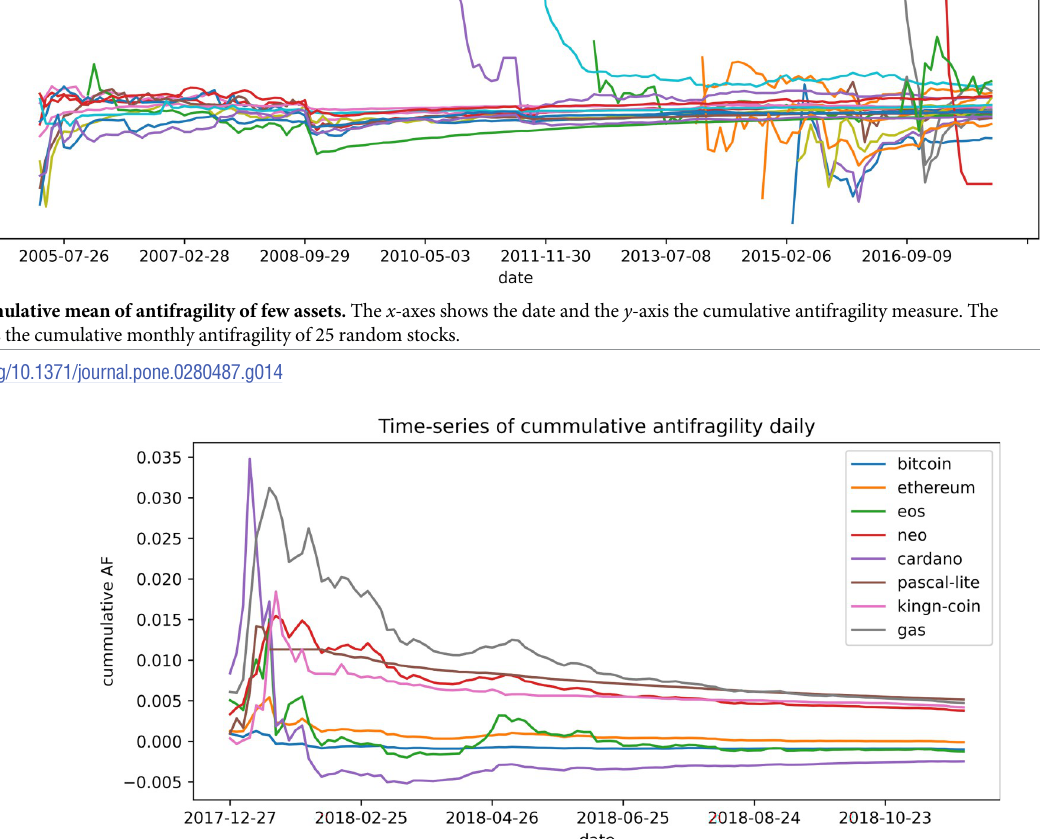
PLOS ONE | https://doi.org/10.1371/journal.pone.0280487 March 16,